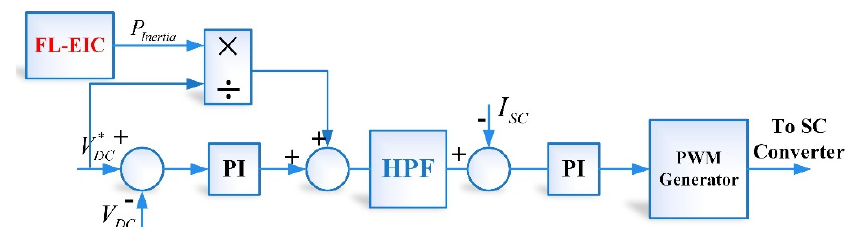
Figure 10. DC voltage controller for SC bi-directional converter.